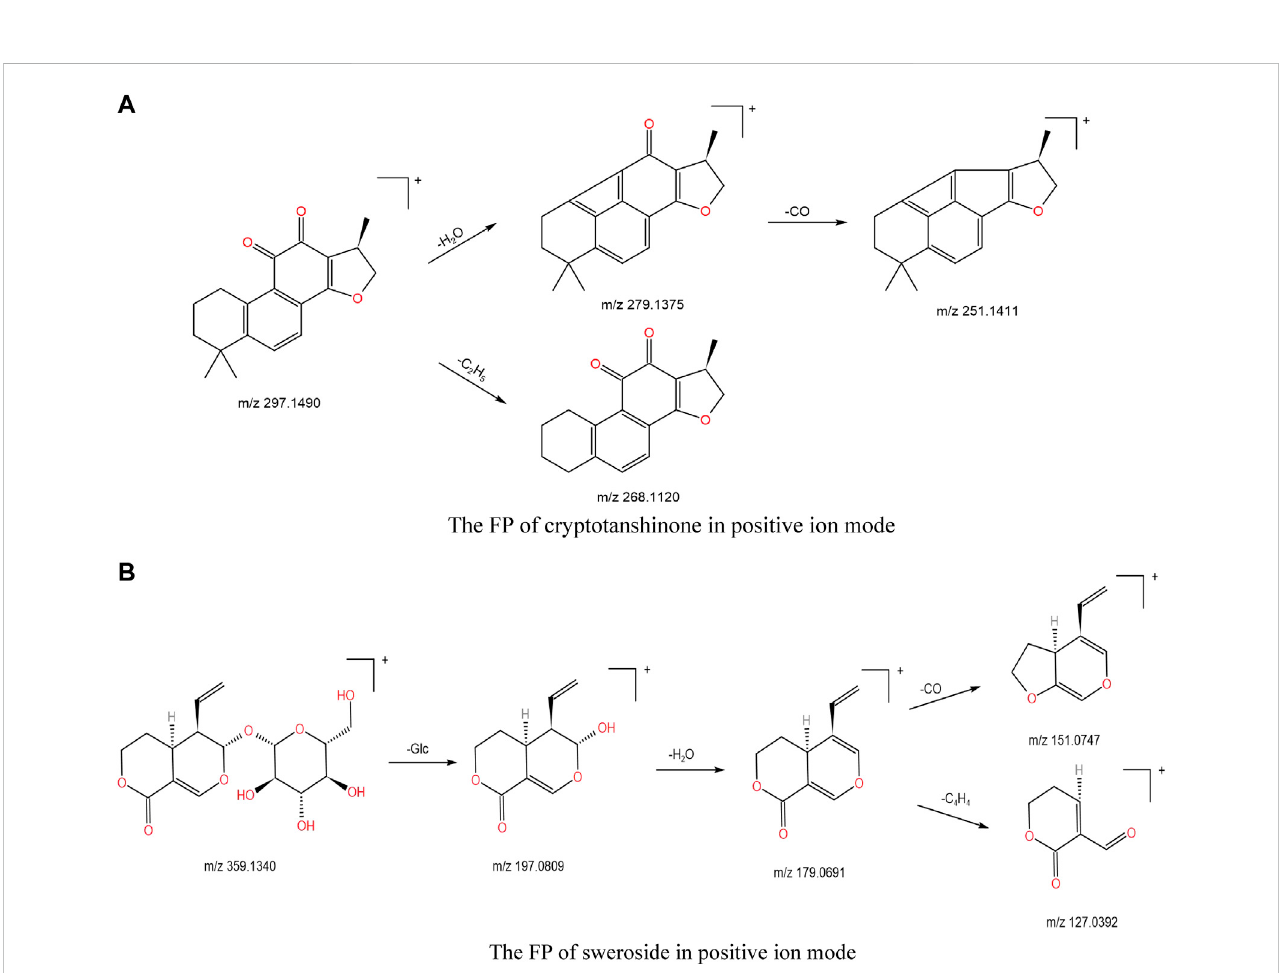
FIGURE 9 (A) The FP of cryptotanshinone in positive ion mode; (B) the FP of sweroside in positive ion